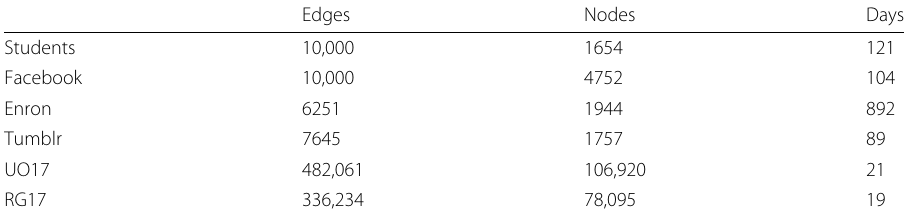
Table 2 Summary of the data sets used Edges Nodes